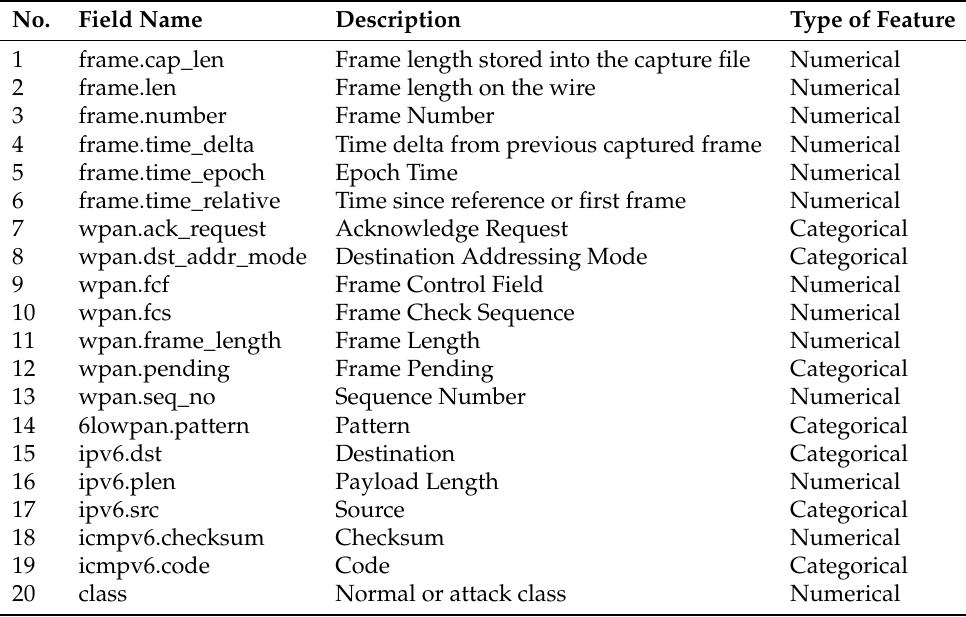
Table 6. Feature descriptions for the data